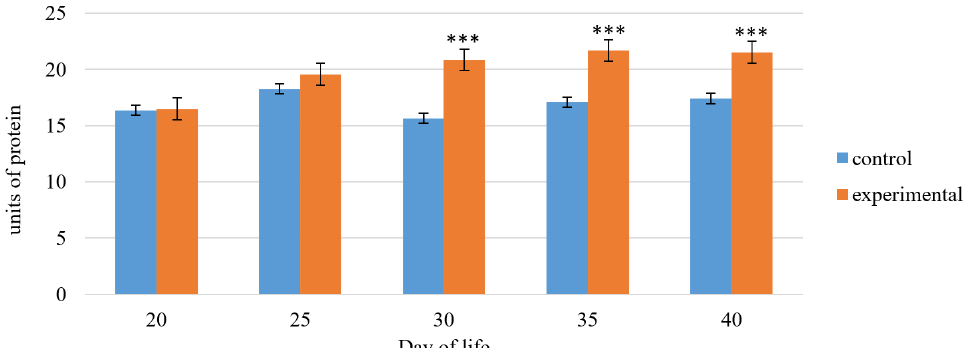
Fig. 1. Superoxide dismutase activity in the blood of piglets under the action of feed additive “Butaselmevit-plus” Given the high-stress sensitivity of piglets, their low re- reactivity. their body. Therefore, to increase the antioxidant sistance and susceptibility to metabolic disorders on the one status of piglets, we used a feed additive “Butaselmevit- hand, and stress during rearing, non-physiological housing plus”, which contains a mixture of ground fruits of milk conditions, and insufficiently balanced feeding – on the thistle, methionine, tocopherol acetate, sodium selenite, and other, it becomes clear the need to use biologically active ascorbic substances to increase resistance and immunobiological